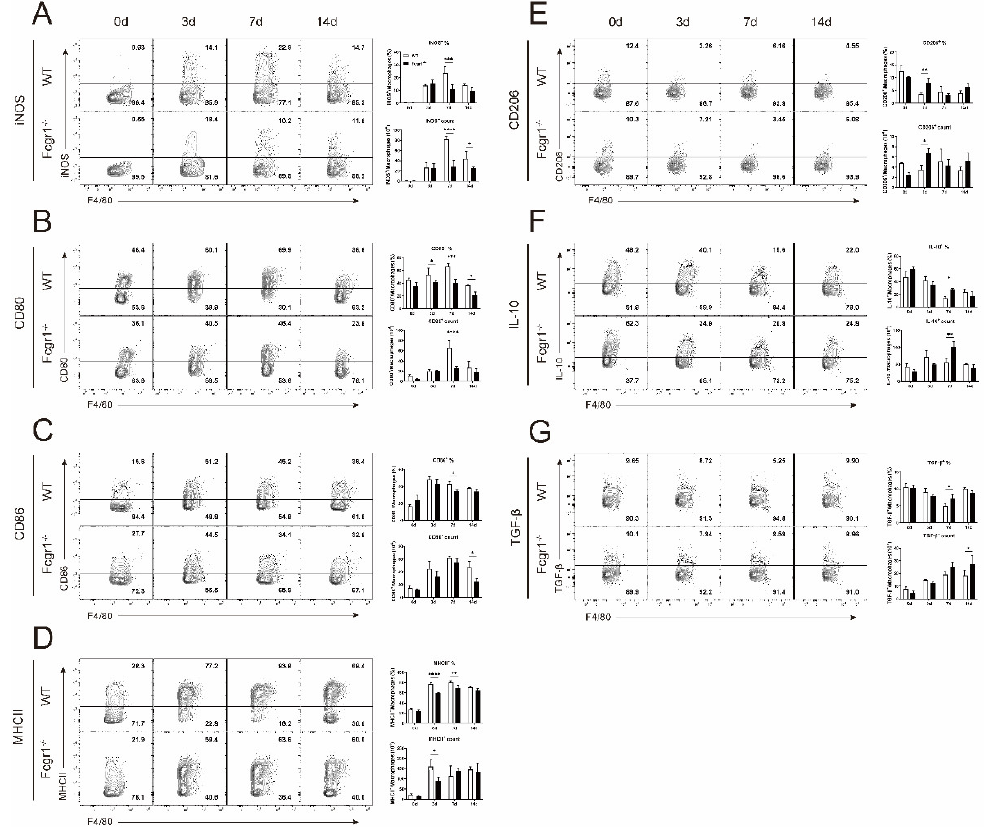
Figure 5. Restricted macrophage polarization towards M1 in Fcgr1 −/− mice after C. muridarum infection. The lung single cells of WT and Fcgr1 −/− mice on days 0, 3, 7, and 14 p.i. were prepared, and the macrophage polarization was examined by flow cytometry. Representative flow cytometric plots (left panel), percentages (top right panel), and total numbers (bottom right panel) of iNOS + macrophages ( A ), CD80 + macrophages ( B ), CD86 + macrophages ( C ), MHCII + macrophages ( D ), CD206 + macrophages ( E ), IL−10 + macrophages ( F ), and TGF−β + macrophages ( G ) are shown. Data are represented as means ± SD from n = 3–5 per group, representative of one of three independent experiments. Statistical significances of differences are determined by two-way ANOVA. * p < 0.05, ** p < 0.01, *** p < 0.001, **** p <